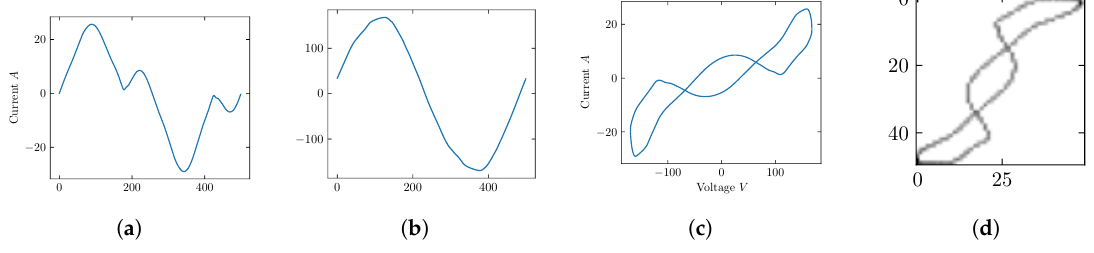
Figure 5. Generation of V–I image from Microwave activation current and voltage in the PLAID dataset: ( a ) Activation current; ( b ) Activation voltage; ( c ) V–I trajectory; ( d ) Generated V–I